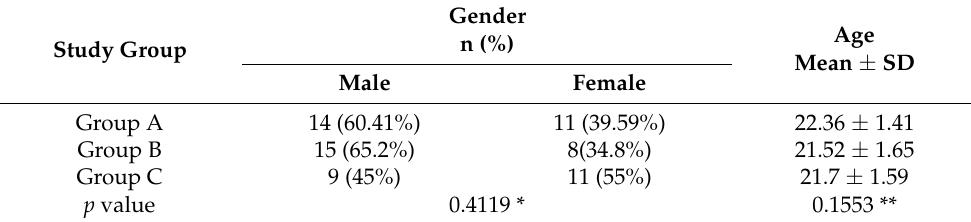
Table 1. Demographic characteristics of the study groups.